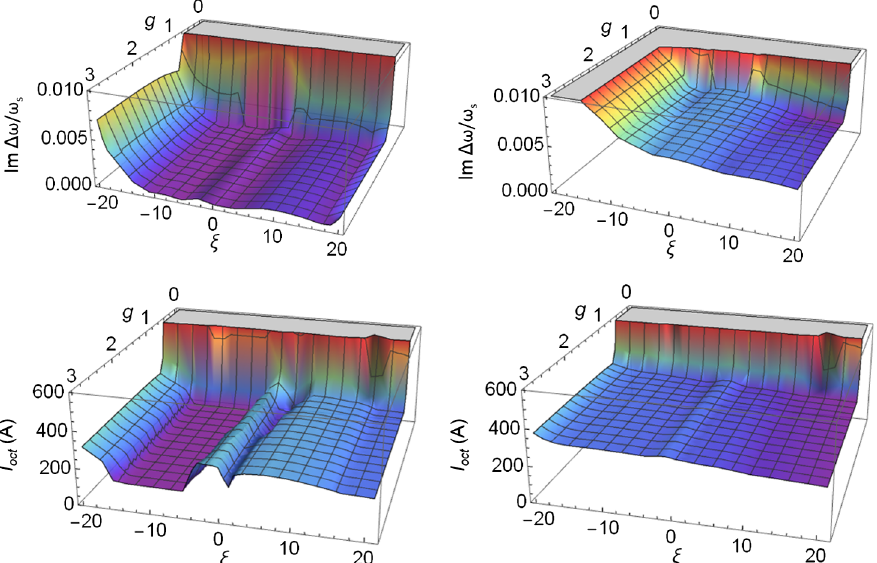
FIG. 10. Compared to the case without the crab HOMs (left), the coupled-bunch dynamics with one dominant HOM (right) depends significantly weaker on the damper gain (g) or the chromaticity ( ξ ). The growth rate of the most unstable coupled-bunch mode is plotted in the top and the corresponding stabilizing octupole current in the bottom. Horizontal plane, R β (cid:1) ¼ 15 cm, E ¼ 7 TeV, 2 . 3 × 10 11 ppb, ϵ ¼ 2 . 1 μ n